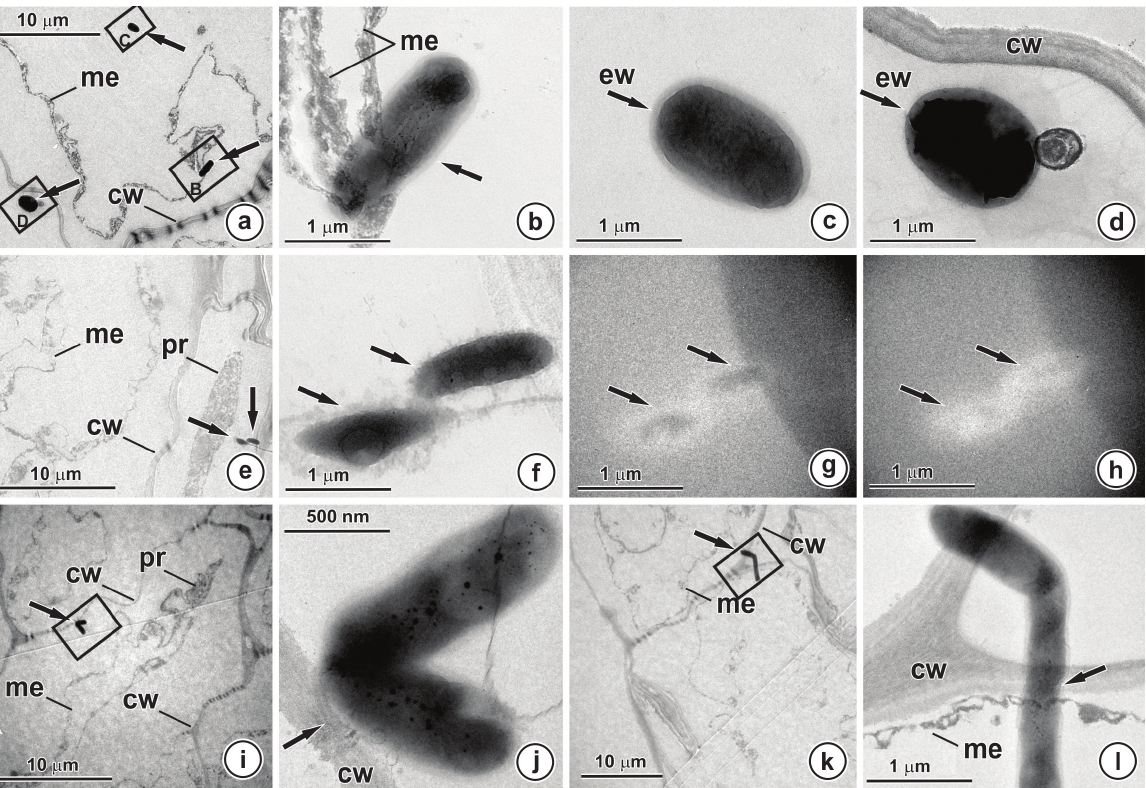
Figure 3 - Ultrastructure of cortical cells of Musa acuminata (Prata-Anã AAB) grown in vitro and colonized by endophytic bacteria. ( a ) ( e ) ( f ) ( i ) Bacillus sp. (EB-40 Isolate) present in the intracellular medium. Cells of the protoplast collapsed, retracted and separated from the plasma membrane of the cellulosic wall; ( b ) Detail of box B, labeled in a. Association of the EB-40 isolate with the plasma membrane; ( c ) detail of box C, labeled in a. The thick wall and heterogeneous cytoplasm of the endophyte; ( d ) Detail of box D, labeled a. Presence of mucilaginous material involving endophytes; ( g ) Detail of box g, labeled in e. Wall of EB-40 isolate with calcium; ( h ) Detail of box h, labeled in e. Wall of isolate EB-40 with nitrogen; ( j ) Detail of box j, marked in i. Intimate association of the EB-40 isolate with the cellulosic wall; ( k ) Association of the EB-40 isolate with the cellulosic wall; ( l ) Detail of box l, labeled in k. The EB-40 isolate traversing the cell wall. Caption: cw: cellulosic wall; ew: endophytic wall; me: membrane; pr: